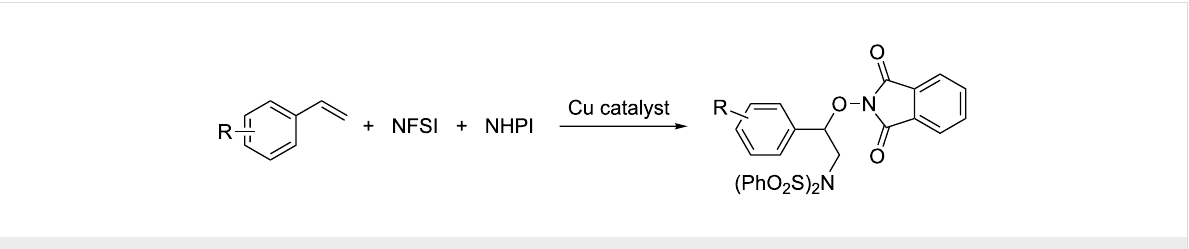
Scheme 1: Copper-catalyzed radical aminooxygenation reaction of